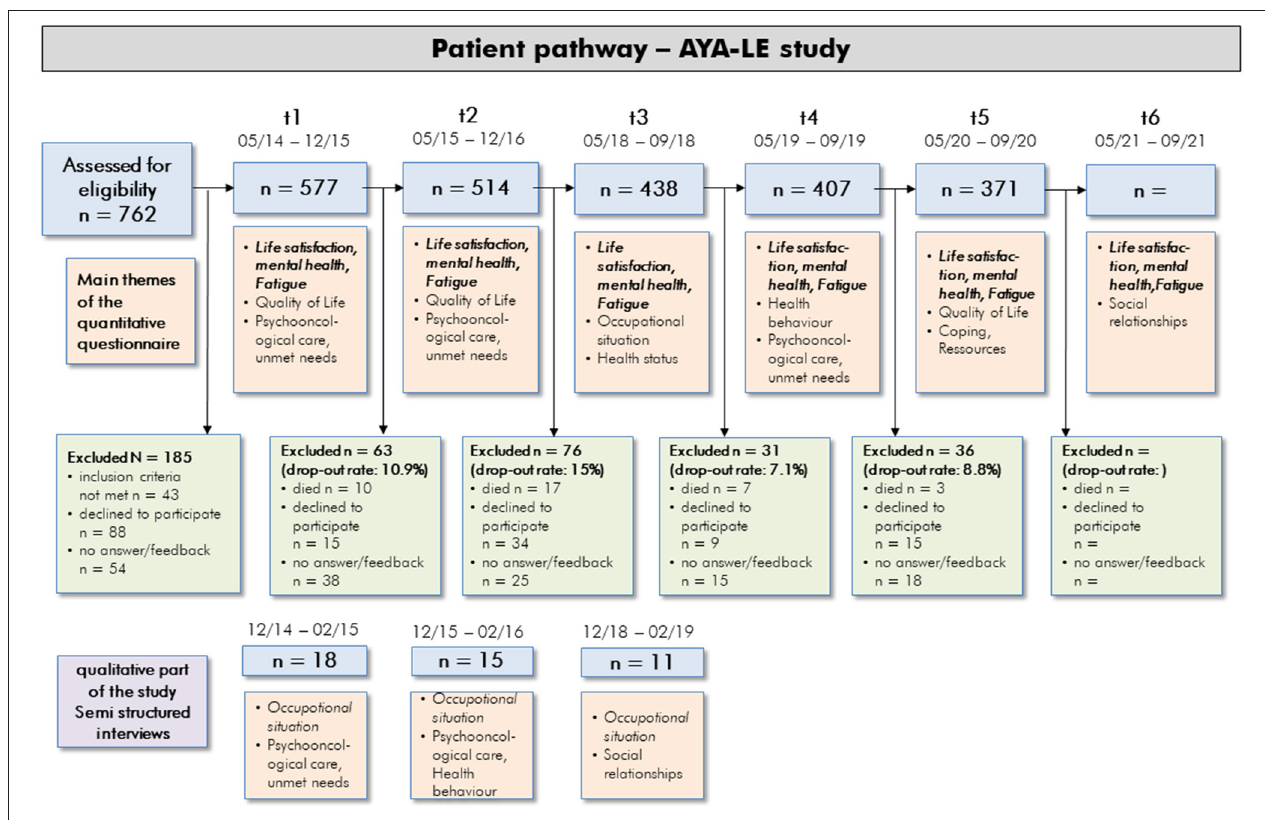
FIGURE 1 | Flowchart of the AYA-Le study participants and main survey